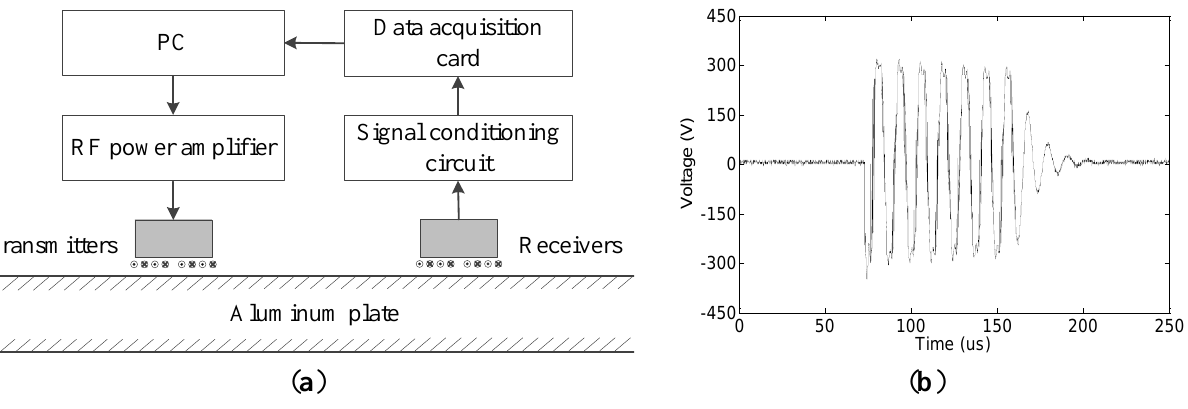
Figure 4. The schematic diagrams of experimental system. ( a ) The experimental system; and ( b ) the tone burst pulse excitation